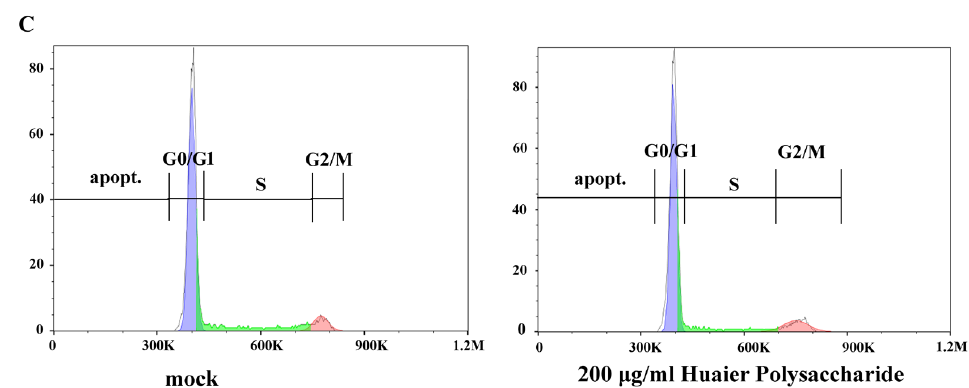
Figure 1. Huaier polysaccharide has no inhibitory effect on PK15 cells’ growth and apoptosis. ( A , B ) PK15 cells were pretreated with different concentrations of Huaier polysaccharide at 37 °C for 24 h or 36 h . Cell viability of PK15 cells was assessed with CCK-8 cell counting assays. ( C ) The apoptosis of PK15 cells treated or not with Huaier polysaccharide (200 mg/mL) was checked by flow cytometry. Significance was analyzed using the one-tailed Student’s t -test. Data are shown as mean ± SD based on three independent experiments. “ns” is not significant.